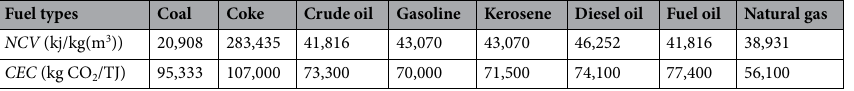
Table 1. Fuel types, net calorific value and carbon emissions coefficient. The data of NCV is from China Energy Statistical Yearbook and the data of CEC is from IPCC 2006.